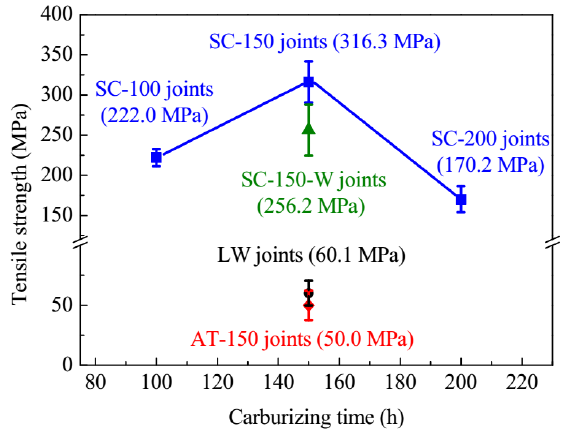
Figure 9. The effect of C addition on tensile strength of the Mo alloy joints [9].